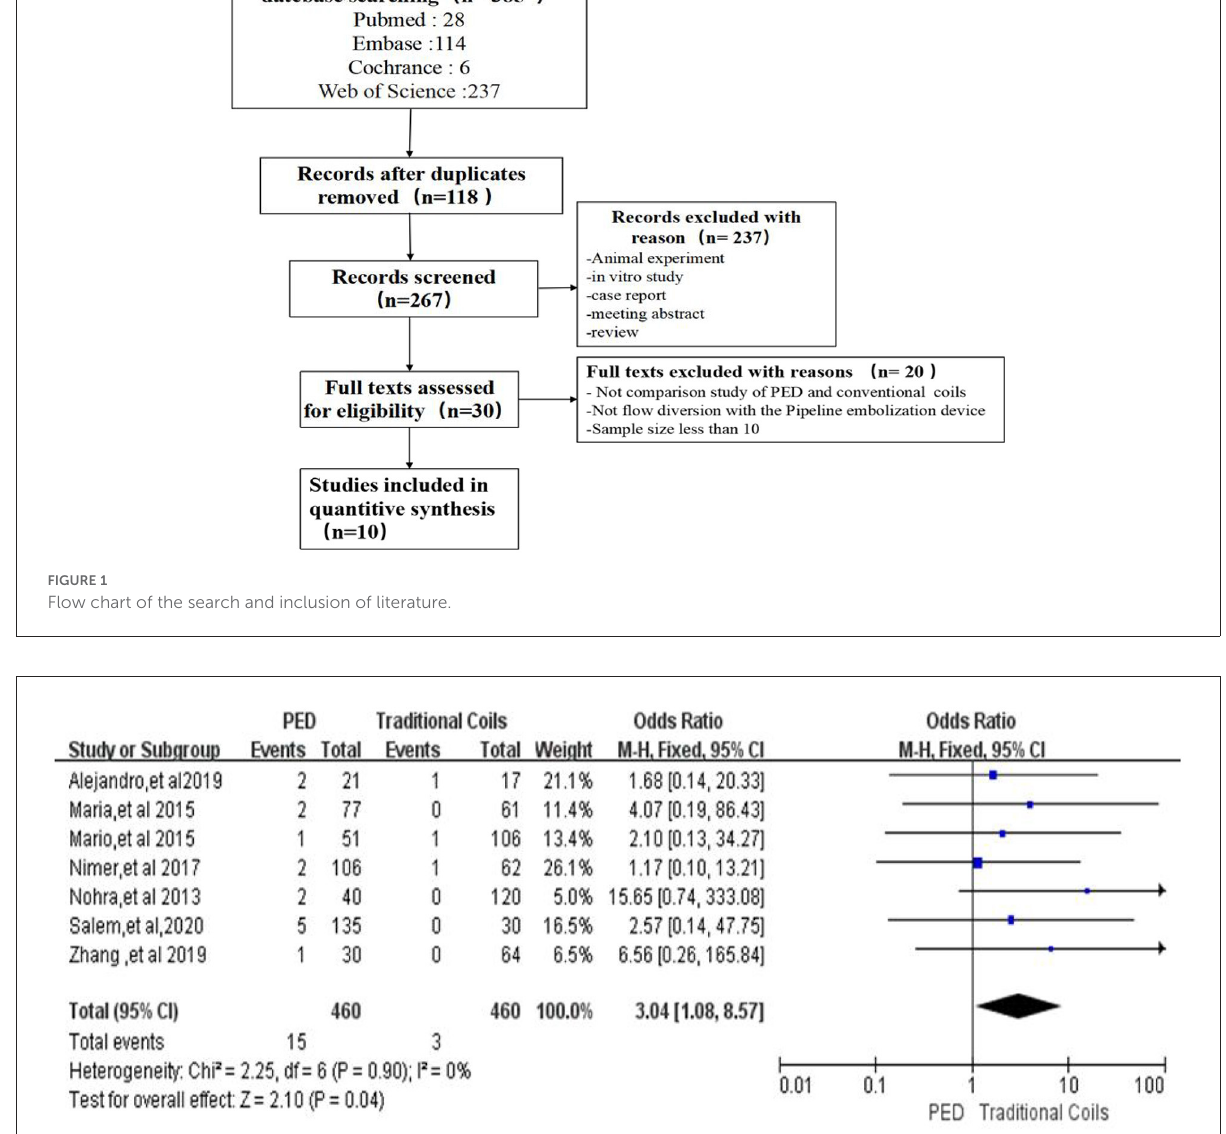
79.3% (410/517) in the PED group and 57.6% (285/495) in the traditional coils group, without affecting the final outcome [OR = 2.62, 95% Cl (1.94, 3.55), p < 0.00001, shown in Figure